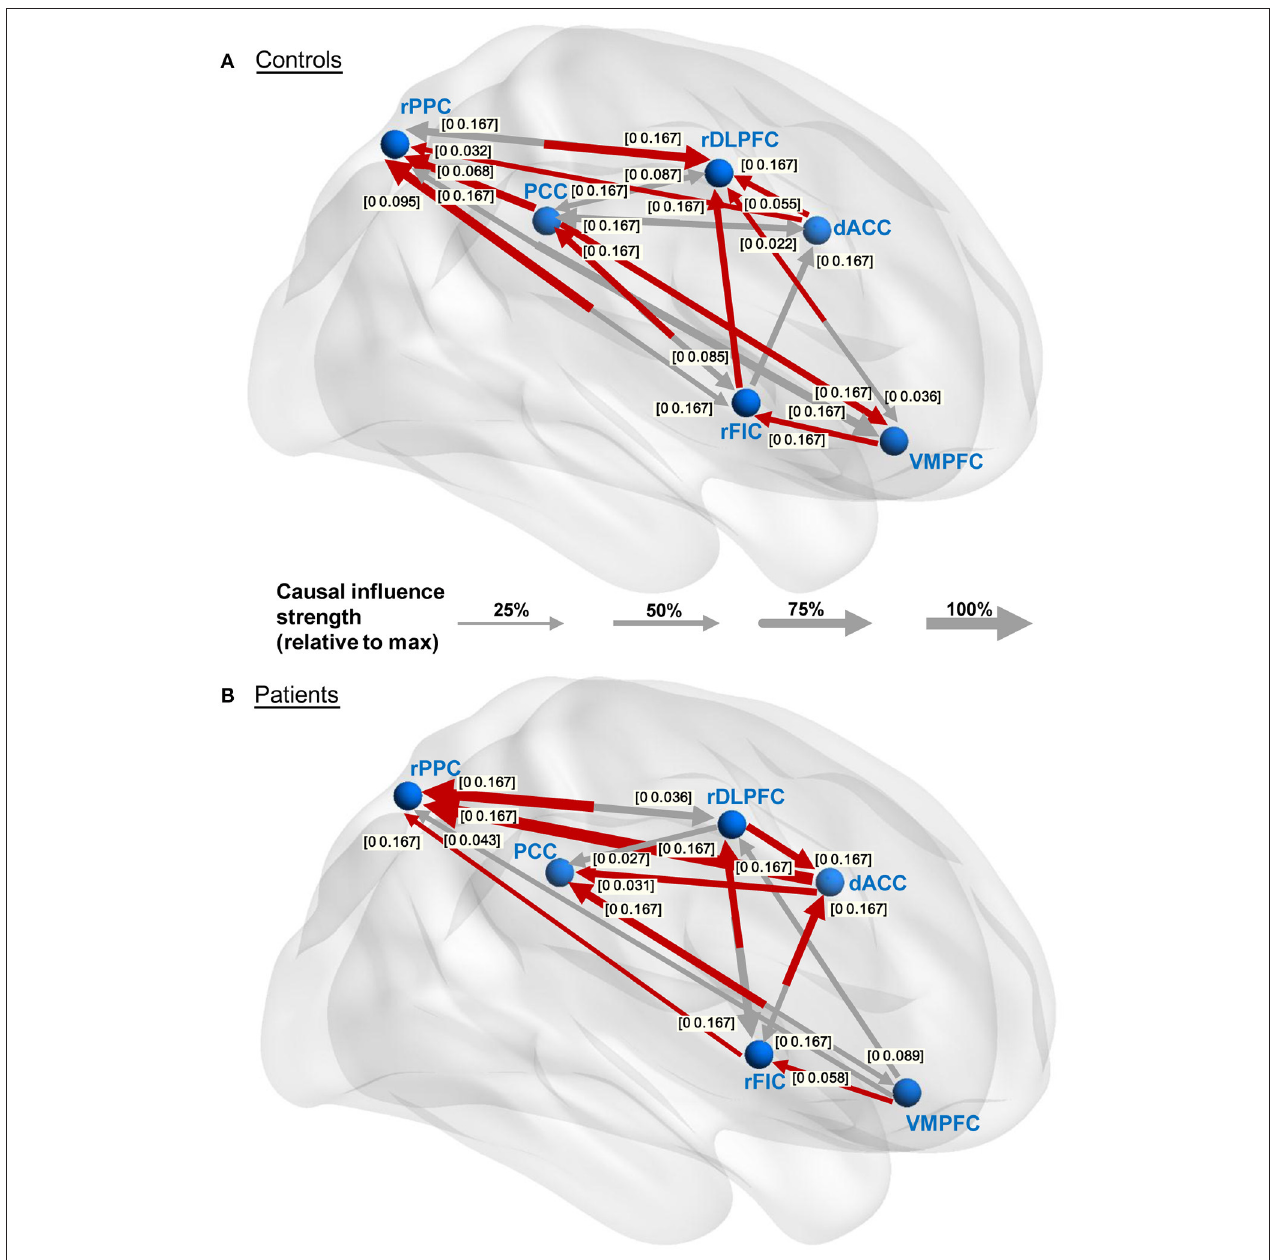
FIGURE 4 | Within-group effective connectivity graphs. (A,B) Effective connectivity graphs of the healthy controls and IGE-GTCS patients, respectively. The connecting lines are weighted according to the normalized partial Granger causality values. The numbers next to the arrowheads indicate the significant frequency intervals of the corresponding connections. The significant connections showing a dominant direction of influence (significant DOI term) are highlighted in